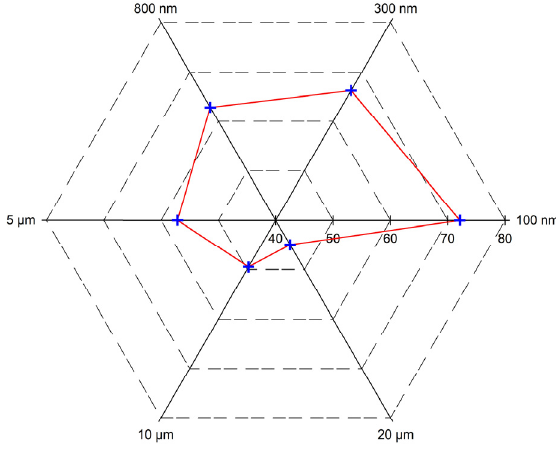
Figure 10. Blocking distance with different sizes of PMs.